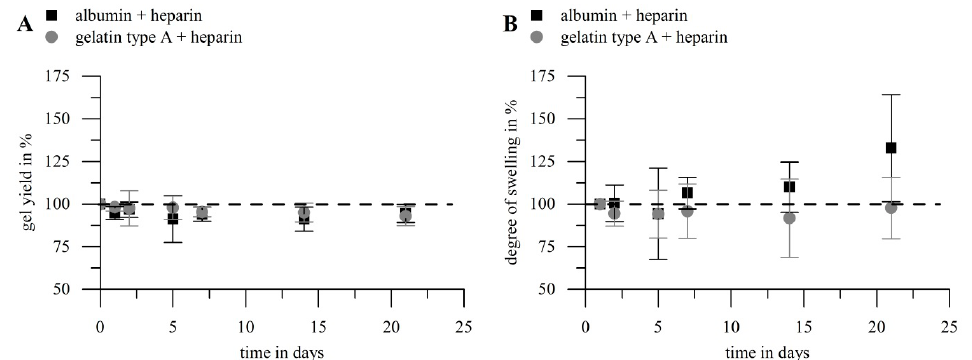
Figure 5. Hydrolytic stability of hydrogels prepared with gelatin (10 wt %) or albumin (10 wt %) and heparin (1 wt %) with 0.125 M EDC. Hydrogels were incubated under the same conditions as for the